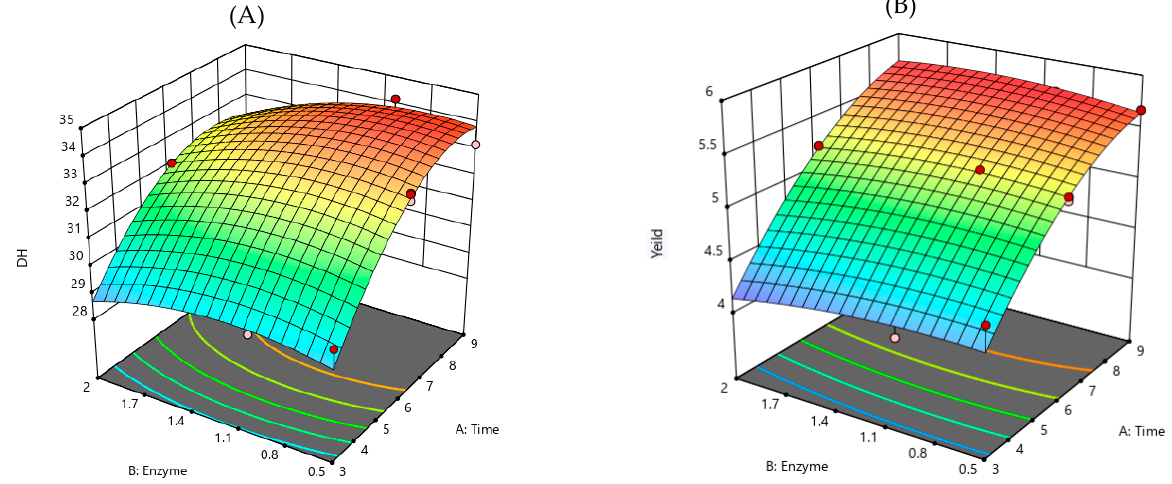
Figure 1. 3D-RMS plots showing the interactive effects of different factors on DH and yield. ( A ) DH of Lingzhi protein hydrolysate on digestion time versus enzyme usage, and ( B ) yield of Lingzhi protein hydrolysate on digestion time.